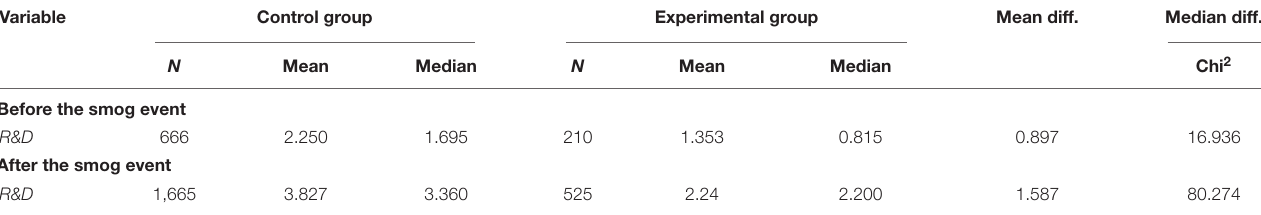
TABLE 4 | Group difference test of enterprise innovation variables. Variable Control group Experimental group Mean diff. Median diff.